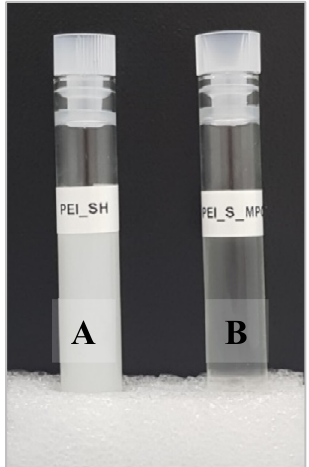
Figure 3. Water solubility of 60 mg / mL thiolated bPEI (bPEI-SH) ( A ) and the grafting complex (bPEI-S-MPC) ( B ).